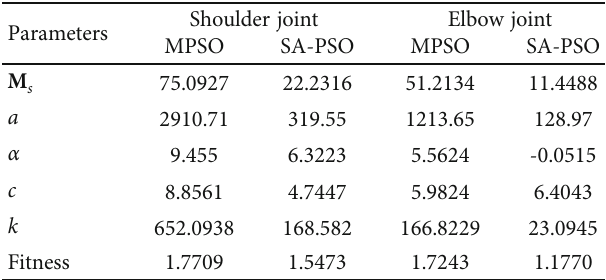
Table 2: Parameter identi fi cation